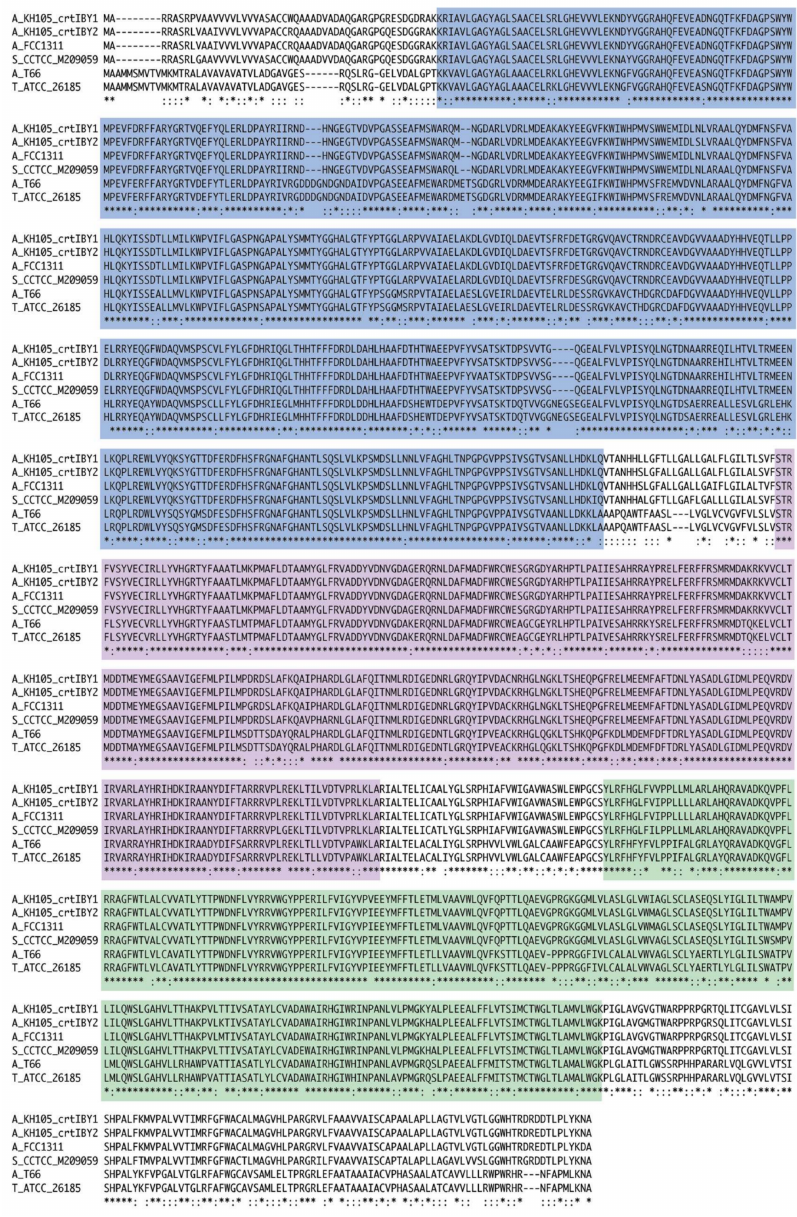
Figure 5. Alignment of amino acid sequences of possible trifunctional β -carotenase synthases, CrtIBY. Sequences of CrtIBY1 and CrtIBY2 of Aurantiochytrium sp. KH105 are compared with those of Aurantiochytrium sp. FCC1311, Schizochytrium sp. CCTCC M209059, Aurantiochytrium sp. T66, and Thraustochytrium sp. ATCC 26185. Blue indicates CrtI, purple, CrtB, and green, CrtY. Asterisks indicate identical amino acid residues; colons denote difference between the upper three and the lower two species; hyphens indicate missing